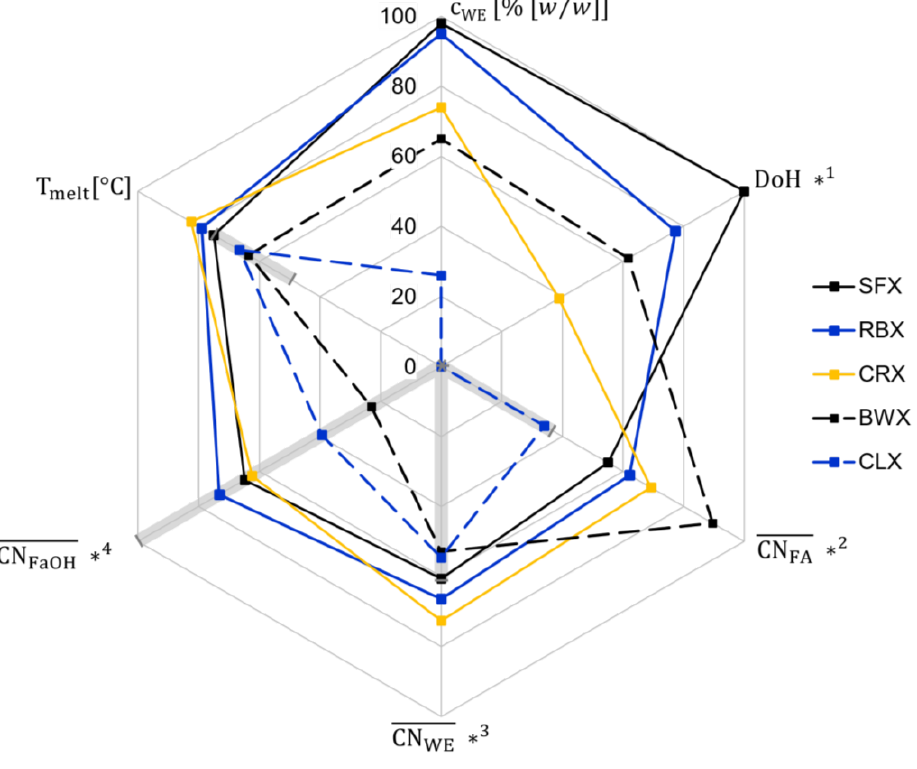
Figure 1. Characteristic parameters of different natural waxes: melting temperature (T melt ), total wax ester (WE) content (% [ w / w ]), degree of homogeneity (DoH), mean total carbon number (CN) of the WE fraction, mean CN of the fatty acid (FA) and fatty alcohol (FaOH) moieties in the WE fraction. Span of axis from center to outer: *1: DoH from 0.23 to 14.27; *2: CN FA from 14 to 24; *3: CN WE from 30 to 56; *4: CN FaOH from 16 to 32. Gray areas: range covered by the WE studied. SFX = sunflower wax, RBX = rice bran wax, CRX = carnauba wax, BWX = beeswax, CLX = candelilla wax.